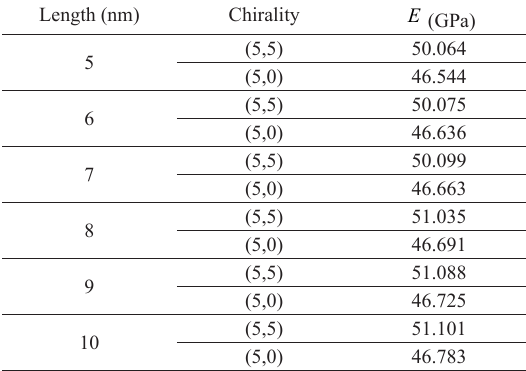
Table 4. Dynamic Young’s modulus (GPa) predicted by MD simulations for different lengths of armchair (5,5) and zigzag (5,0) SiNT. Length (nm)